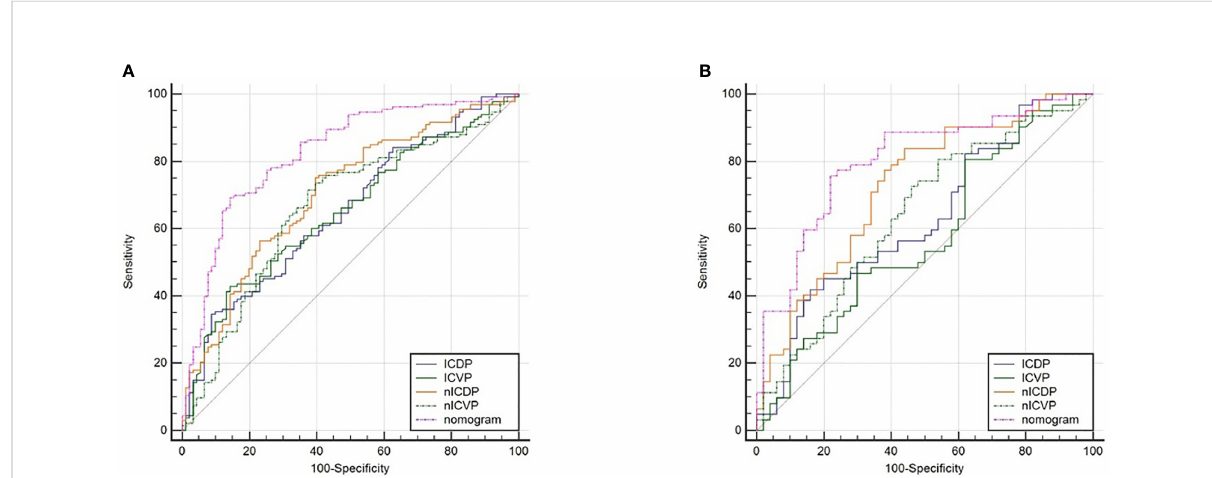
FIGURE 5 ROC analyses of IC parameters and the nomogram for the prediction of lymphovascular invasion in the primary dataset (A) and validation dataset (B) . The nomogram yielded the highest area under the curve of 0.825 (95%CI, 0.769-0.872) in the primary dataset and 0.802 (95%CI, 0.716-0.871) in the validation